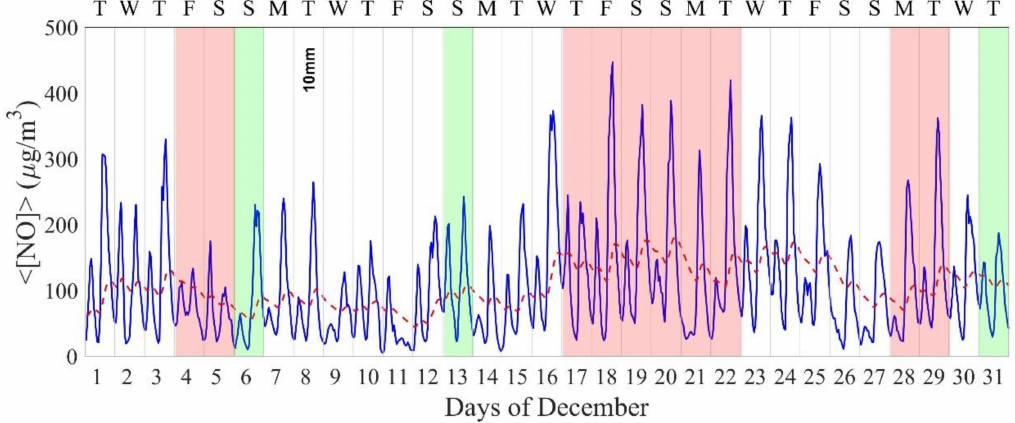
Figure 10. Nitric oxide concentration variation related to the total block of urban traffic (green band) and alternated plates (red band) of December 2015. The blue line is the hourly pollutant concentration. The red dashed line is the daily mean pollutant concentration. Data of daily precipitation are indicated in